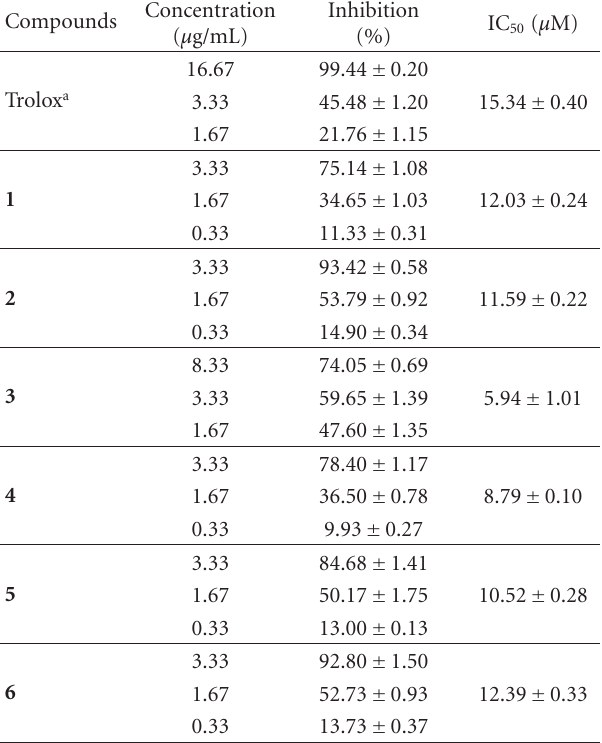
Table 7: Antioxidant e ff ects of the compounds isolated from the P. vulgaris L. on inhibition of the ABTS • + .